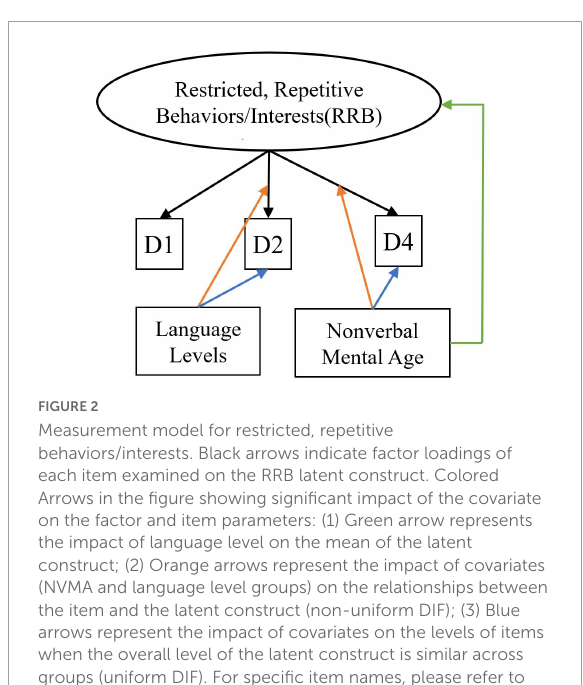
FIGURE2 Measurement model for restricted, repetitive behaviors/interests. Black arrows indicate factor loadings of each item examined on the RRB latent construct. Colored Arrows in the figure showing significant impact of the covariate on the factor and item parameters: (1) Green arrow represents the impact of language level on the mean of the latent construct; (2) Orange arrows represent the impact of covariates (NVMA and language level groups) on the relationships between the item and the latent construct (non-uniform DIF); (3) Blue arrows represent the impact of covariates on the levels of items when the overall level of the latent construct is similar across groups (uniform DIF). For specific item names, please refer to Table 2